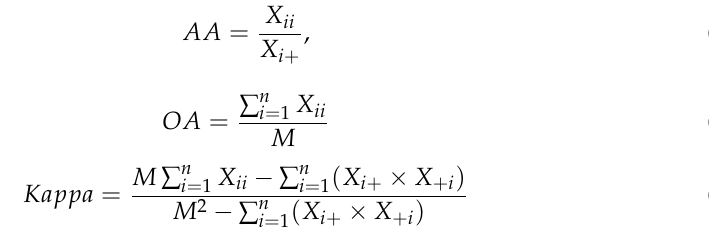
Figure 6. Convolutional block attention module prototypical networks (CBAM-P-Net) classification framework.